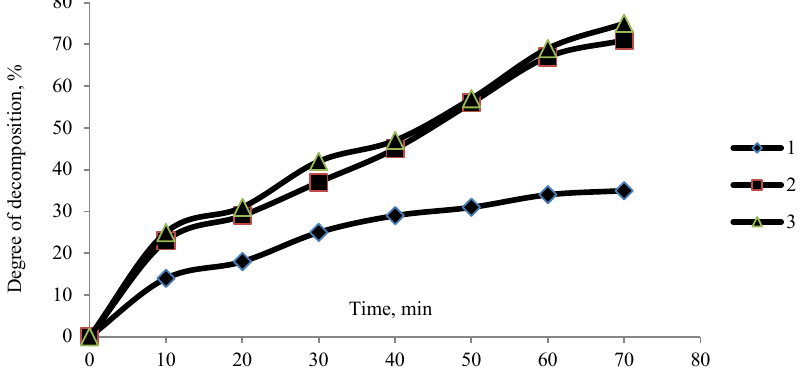
Fig. 3. The dependence of the level of purification of the solution from phenol on the duration of the treatment and the volume ratio ‘simulated solution: anolyte’. Phenol concentration 1 mg/l. Volume ratio ‘simulated solution: anolyte’ 1–10 6 ; 2–5 · 10 5 ; 3–10 5